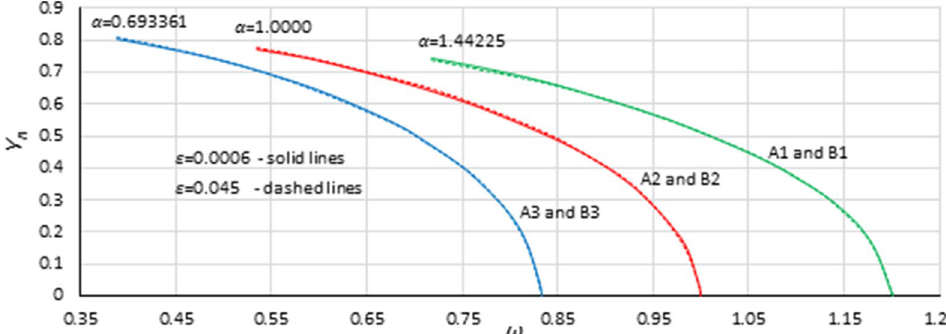
Figure 10. Comparison of curves of the origin point P B for cases A1 (green solid line), A2 (red solid line), A3 (blue solid line) and B1 (green dashed line), B2 (red dashed line), and B3 (blue dashed line), all recalculated for nondimensional value Y n according to formula